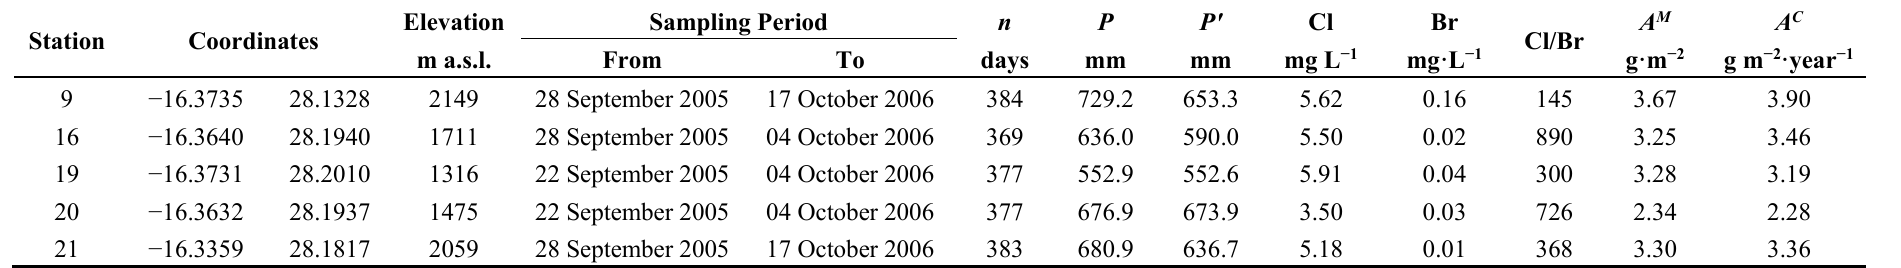
Table 1. Yearly atmospheric chloride bulk deposition data from 5 non-permanent open collectors in the Las Cañadas Caldera area. Station Coordinates